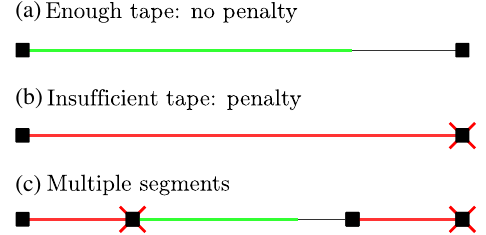
FIG. 2. 1D Robinson tiling analog, the marker Hamiltonian: The penalty between halting and not halting for the TM is flipped ; i.e., we penalize not halting (the TM head moves past the available tape, or equivalently, the clock driving the TM runs out of space — see Remark 19). (a) If the tape — delimited by a black segment marker — is long enough for the TM to terminate, there is no penalty. (b) If the tape is too short, a penalty is inflicted due to the head running into the right segment marker. (c) Mixed- length segments, each delimited with a segment marker. Those segments for which there is insufficient tape space pick up a penalty due to halting. The final construction introduces a small bonus for each segment, which shrinks the longer the segment is, and which is always smaller (in modulus) than the penalty that could be inflicted on the TM running on the available tape. In the halting case, this results in the lowest-energy configuration being evenly spaced segments with just enough tape for the TM to halt. In the nonhalting case, a single segment is most